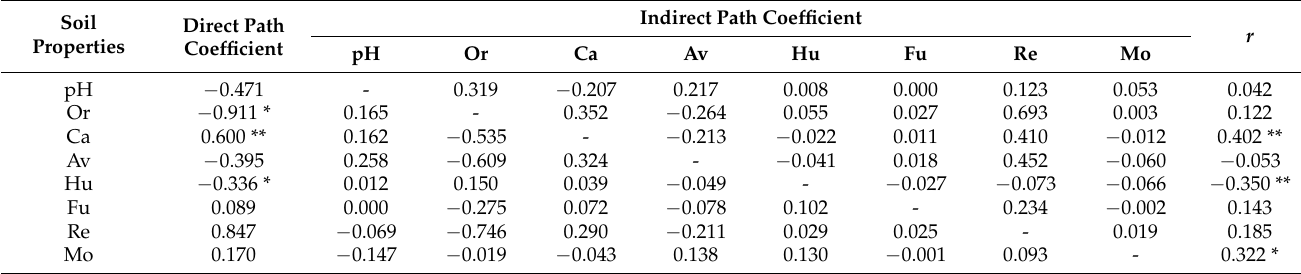
Table 5. Path analysis between soil properties and